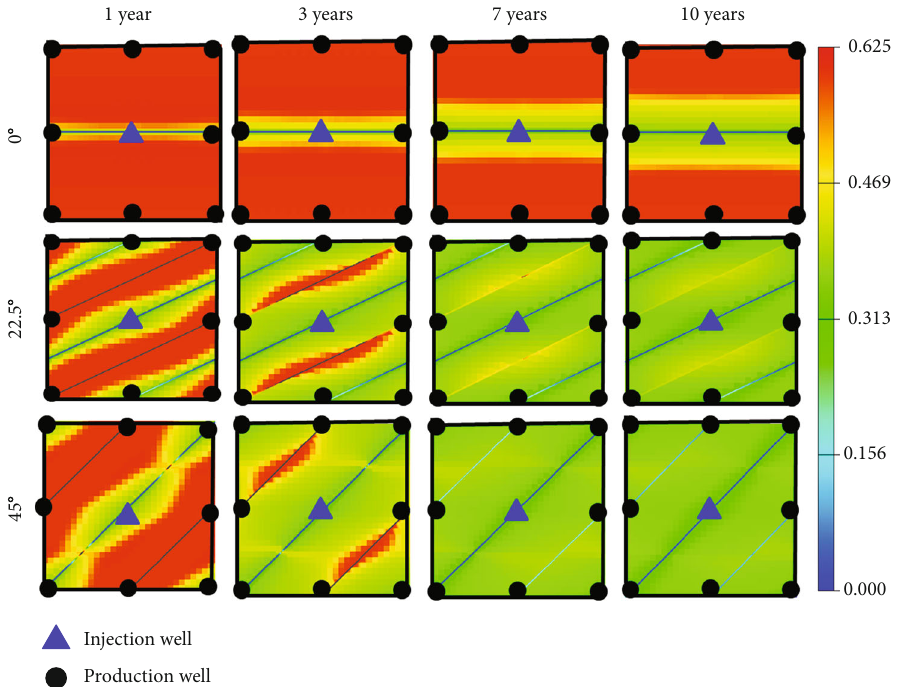
Figure 4: Planar distribution of the remaining oil saturation at di ff erent intersection angles and times. Table 3: Comparison of the results for the di ff erent angles.